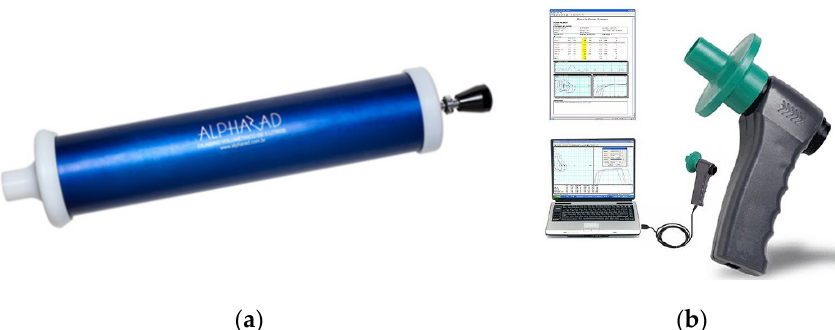
Figure 3. Components for calibrating the spirometer: ( a ) Calibration syringe; ( b ) Koko flow spirometer model 313105.